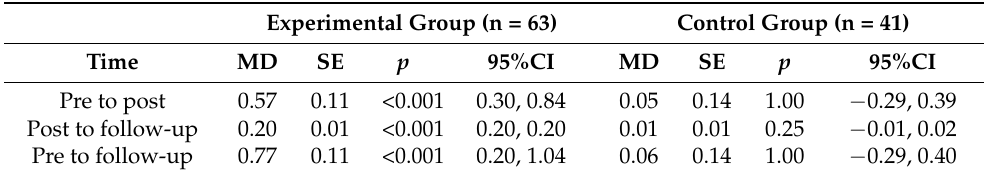
Table 2. Pairwise comparisons in the experimental and control groups of TEC scores between assessment time periods from pre- to post-intervention, post-intervention to follow-up, and pre- intervention to follow-up.